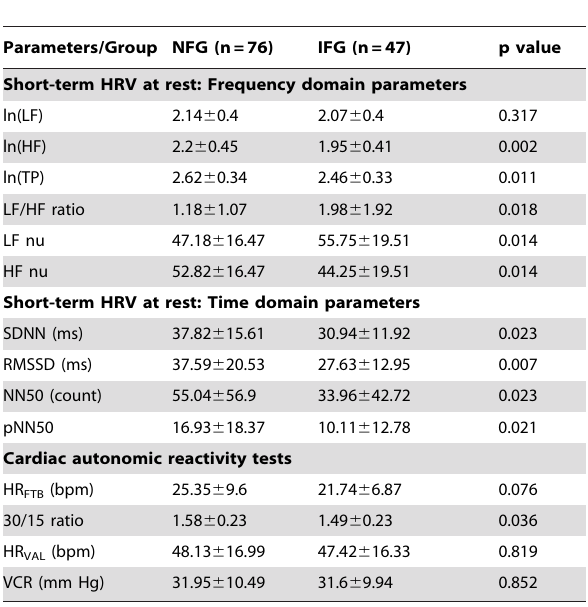
Table 4. Comparison of biochemical parameters between NFG and IFG group.